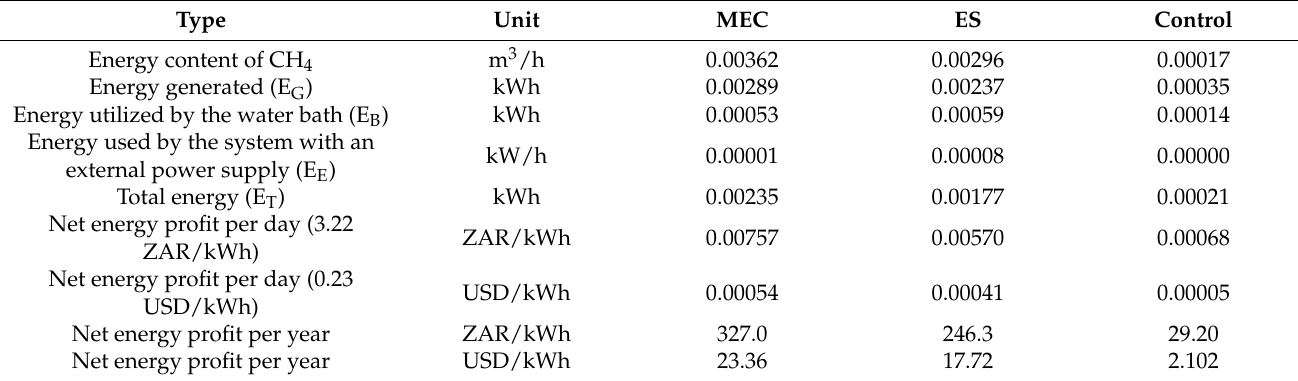
Table 4. Economic and energetic viability of the processes.